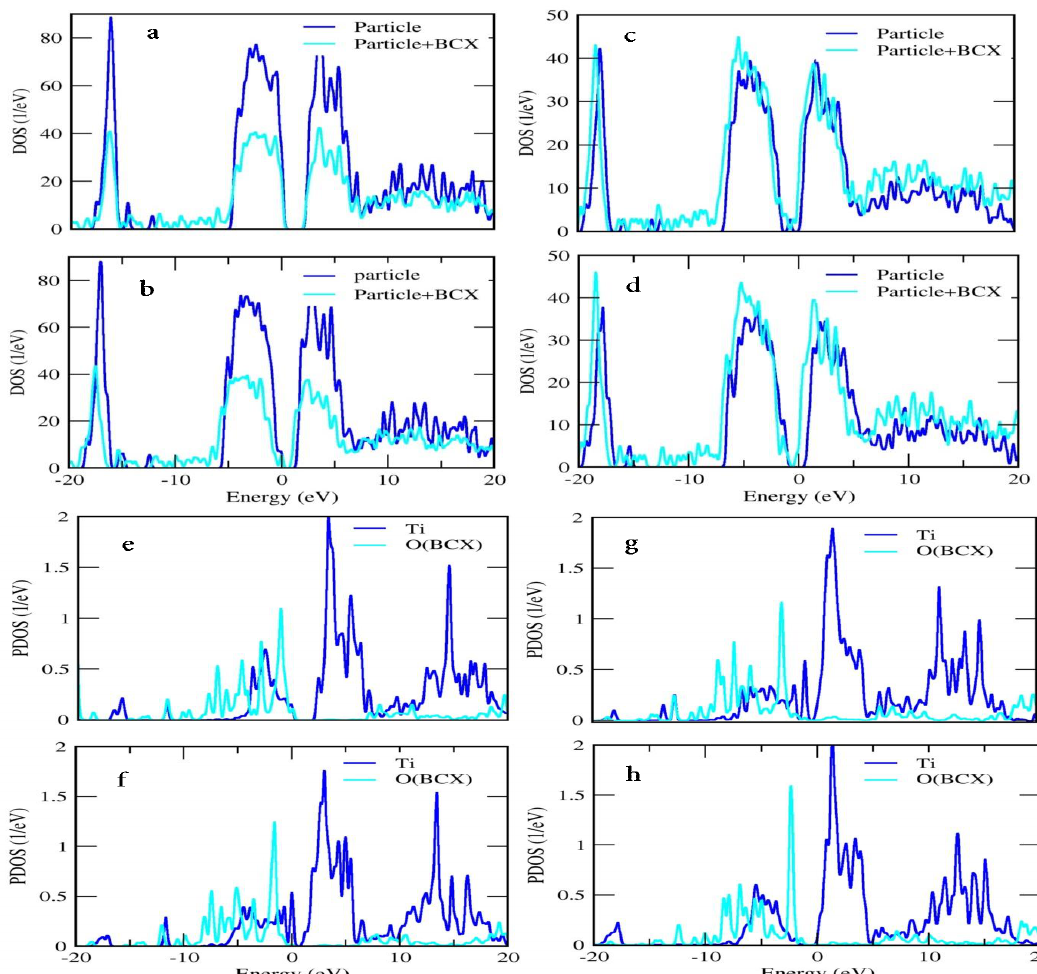
Fig. 4. Total and projected density of states for the considered systems consisting of the IMMUCILLIN-A molecule adsorbed on the N-doped TiO anatase nanoparticles in before and after the adsorption process, (a, e) Configuration A; (b, f) Configuration B; (c, g) 2 Configuration C; (d, h) Configuration D.